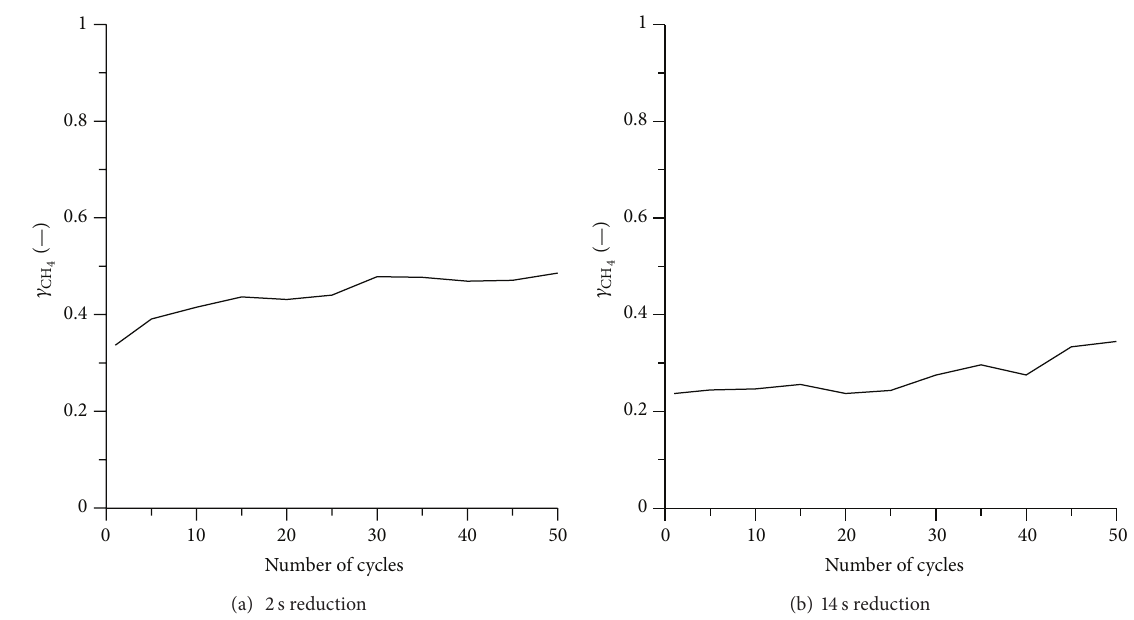
Figure 13: Methane conversion, ( 𝛾 ) as a function of number of cycles for 5.6% MgO 1300 oxygen carrier. CH 4